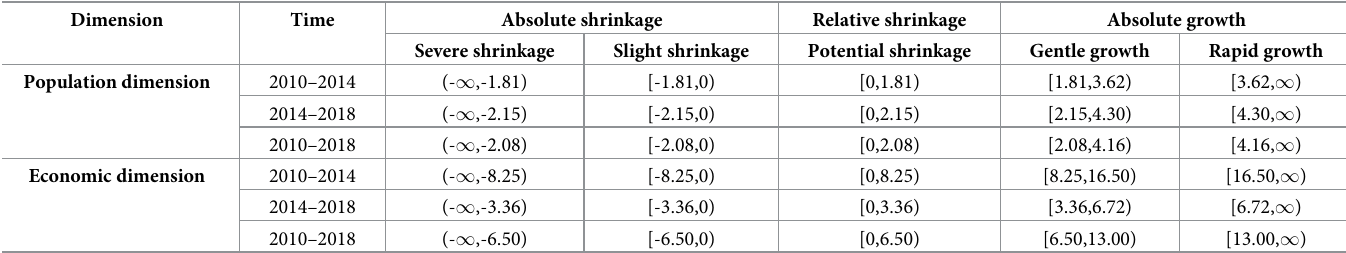
Table 1. The definition and classification of cities in the Yellow River Basin in population and economic dimensions in different periods (%).